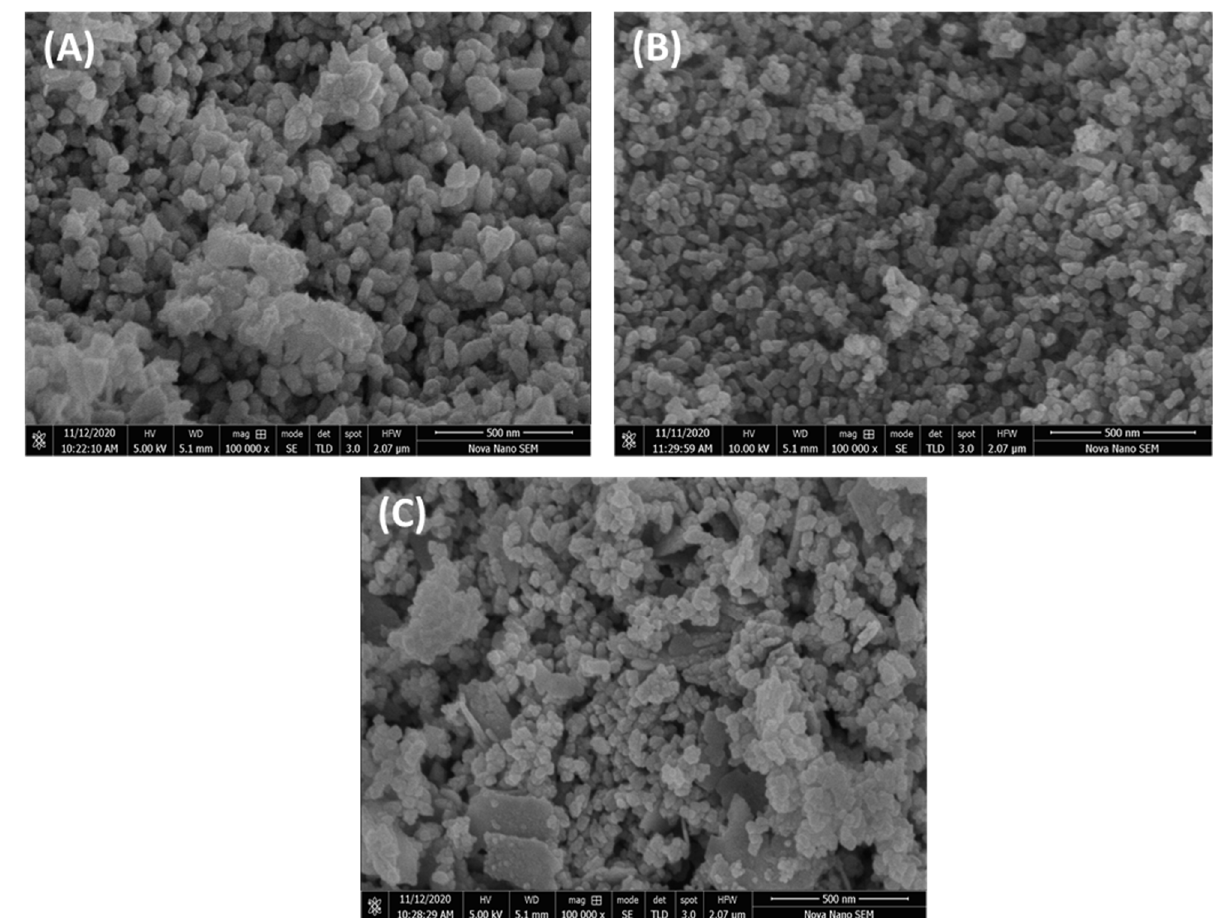
Figure 2. SEM micrographs of ( A ) ZnO, ( B ) CuO nanoparticles and ( C ) ZnO/CuO nanocomposite.